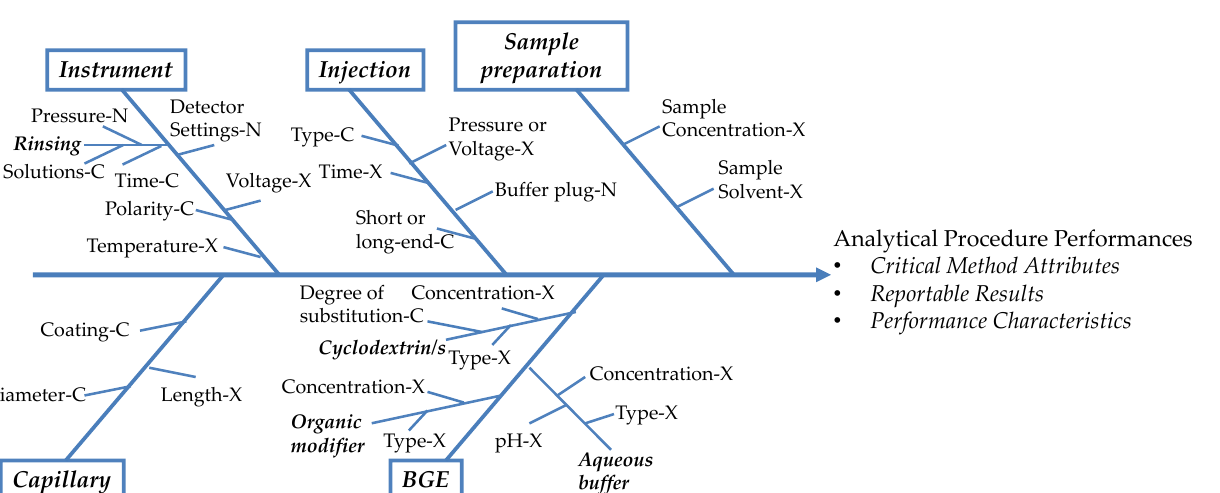
Figure 6. DoE strategy for chiral CE.